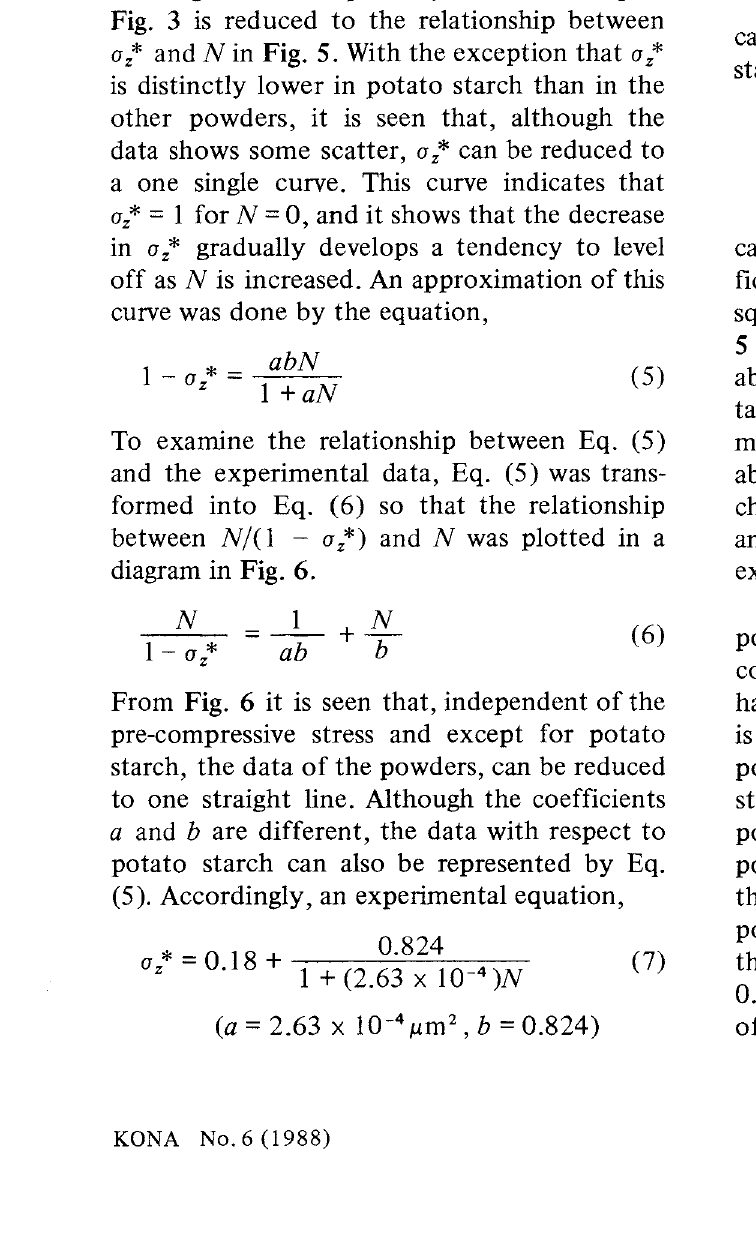
Fig. 5 Relationship between az* and number of additives per unit powder surface area